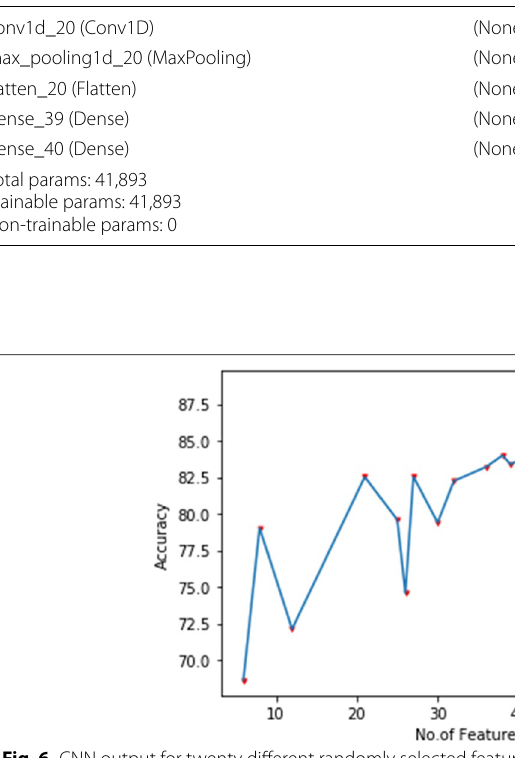
Fig. 6 CNN output for twenty different randomly selected